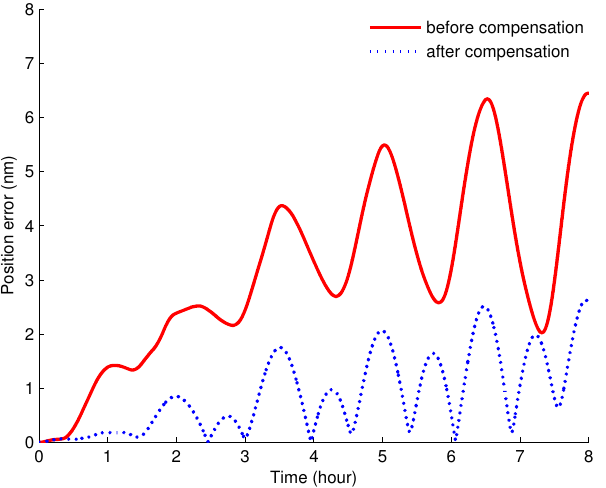
Figure 14. The curves of the position error before and after